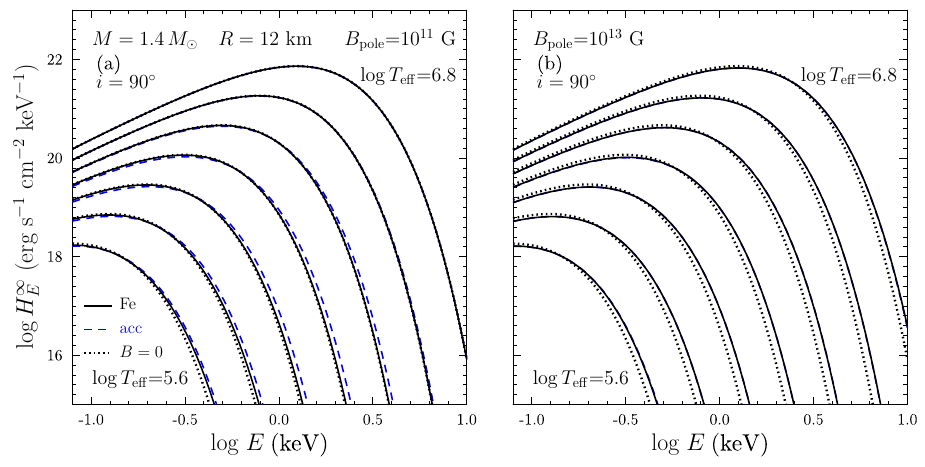
Figure 4. Same as in Figure 3 but for equator observations at B pole = 10 11 G ( a ) and 10 13 G ( b